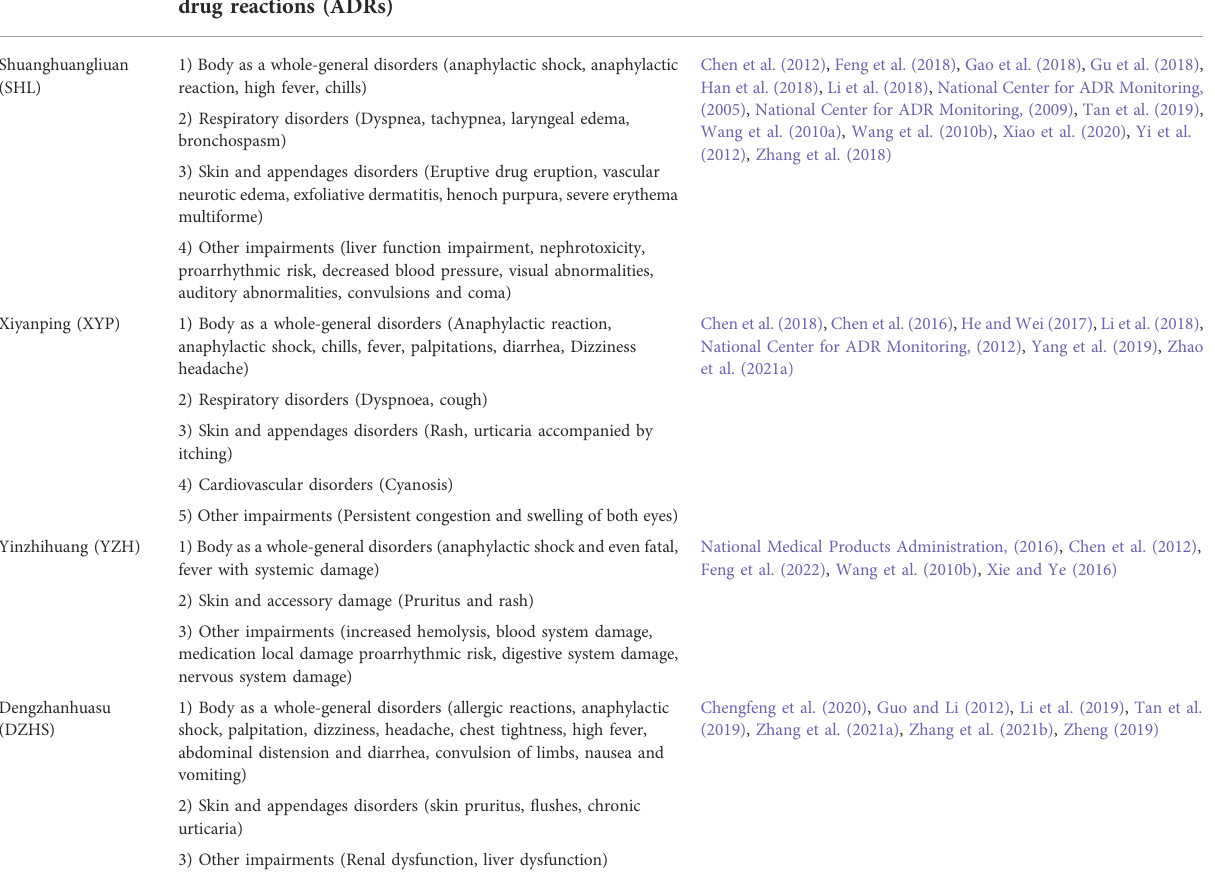
TABLE 3 The ADR reports of SHL, XYP, YZH, and DZHS